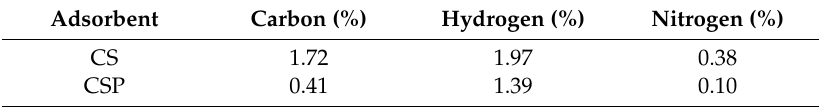
Table 1. Elemental analysis of carbon, Hydrogen and Nitrogen of CS and CSP adsorbents. Adsorbent